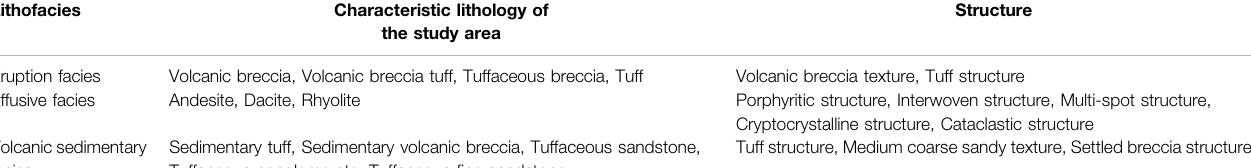
TABLE 1 | Lithology and structural characteristics of the Mesozoic volcanic rocks in the D Oil fi eld.